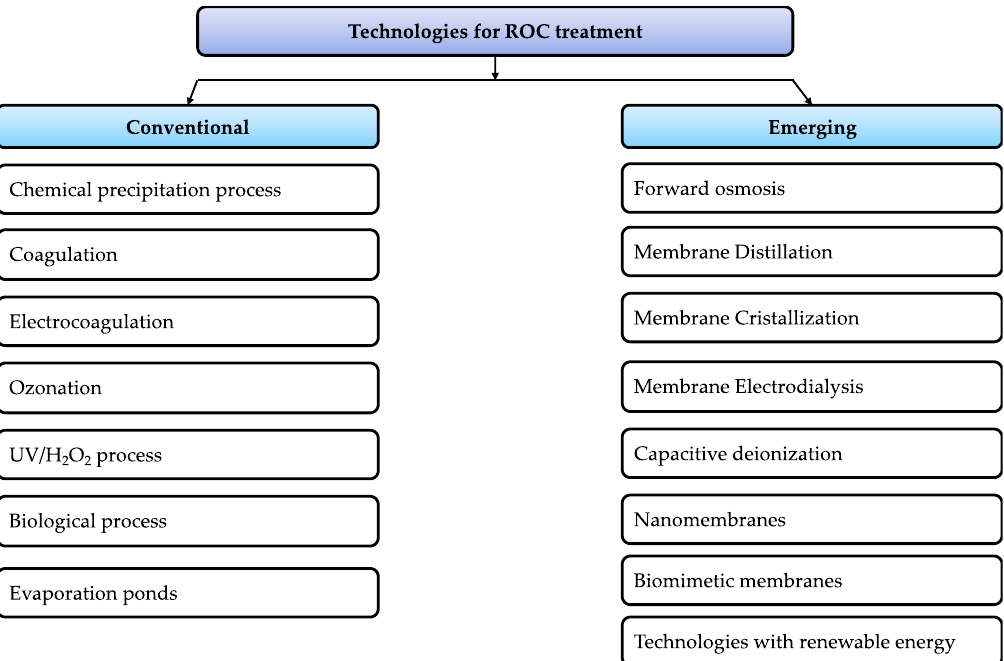
Figure 5. Schematic classification of technologies for ROC treatment.